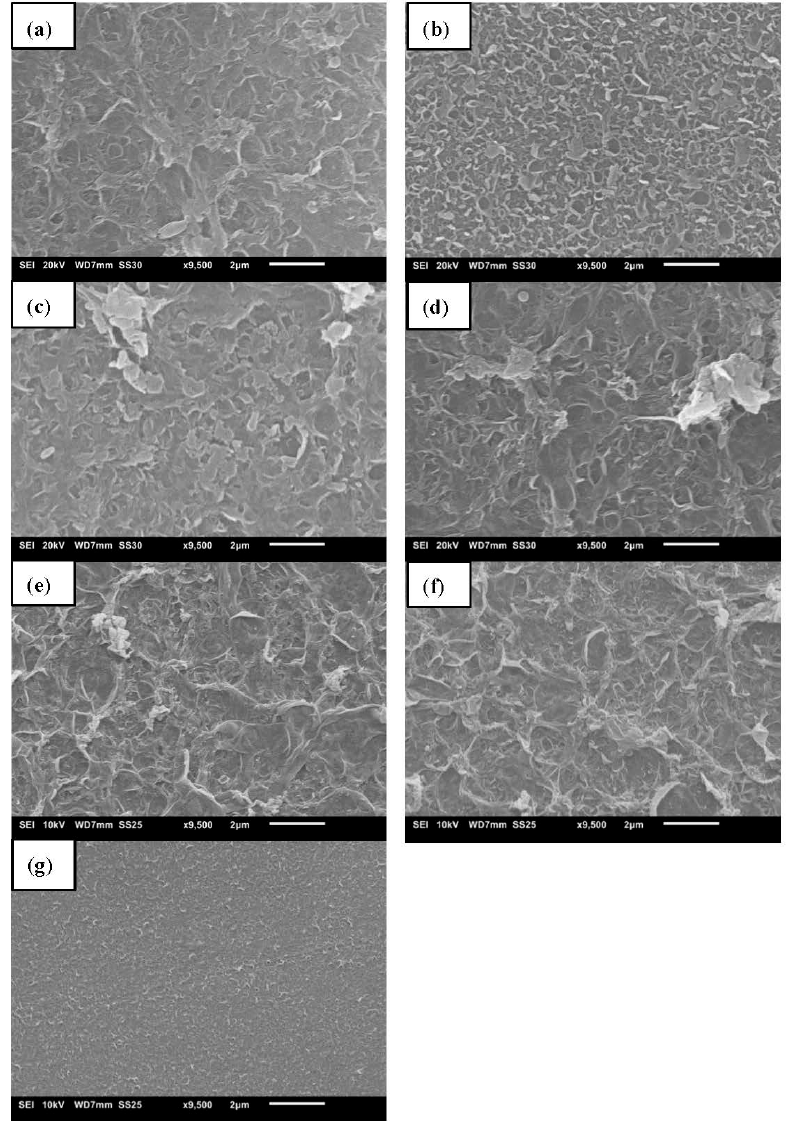
Figure 9. SEM surface images of PA TFC membranes synthesized on UV-cured PSf supports with initial PSf concentrations of ( a ) 10, ( b ) 12, ( c ) 14, ( d ) 16, ( e ) 18, ( f ) 20, and ( g ) 22 wt%.